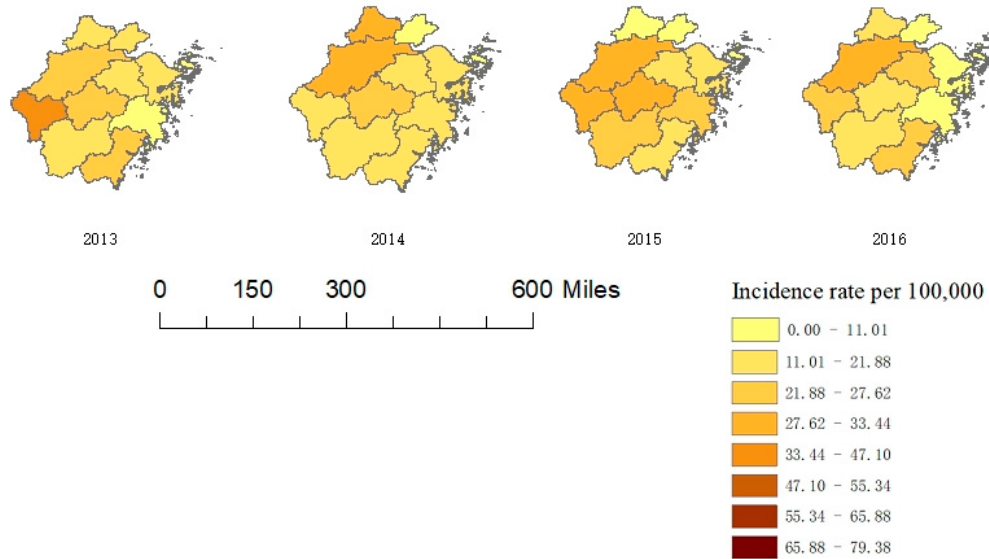
Figure 3. TB incidence rates among full-time teachers in Zhejiang province, 2005–2016.